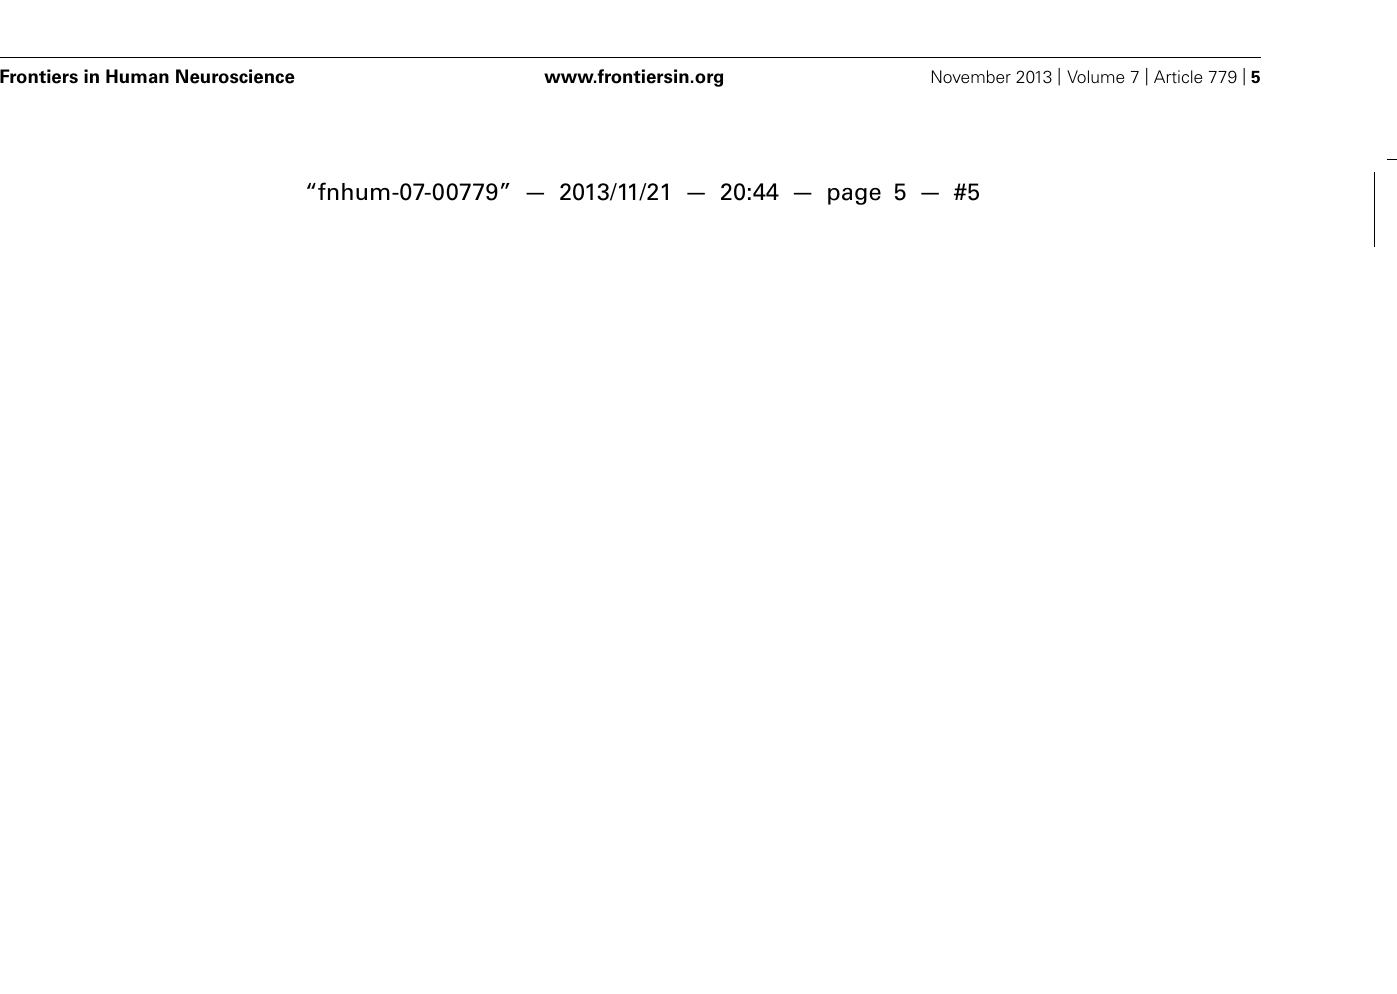
FIGURE 3 | Grand-average ( ± SEM) time course of prefrontal cortex O 2 Hb (red lines) and HHb (blue lines) concentration changes (vertical axis) over the left and right hemisphere during memory encoding (horizontal axis: time) for the silence (right side) and